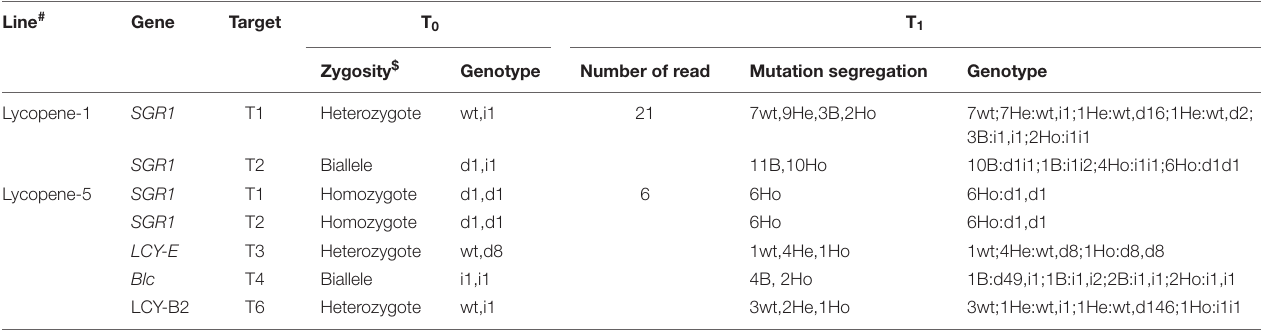
TABLE 1 | Segregation patterns of CRISPRCas9-medicated targeted mutagenesis during the T 0 to T 1 generation. Line